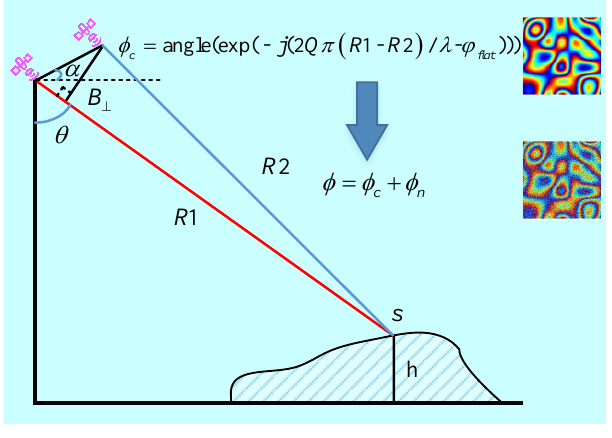
Figure 1. InSAR geometry